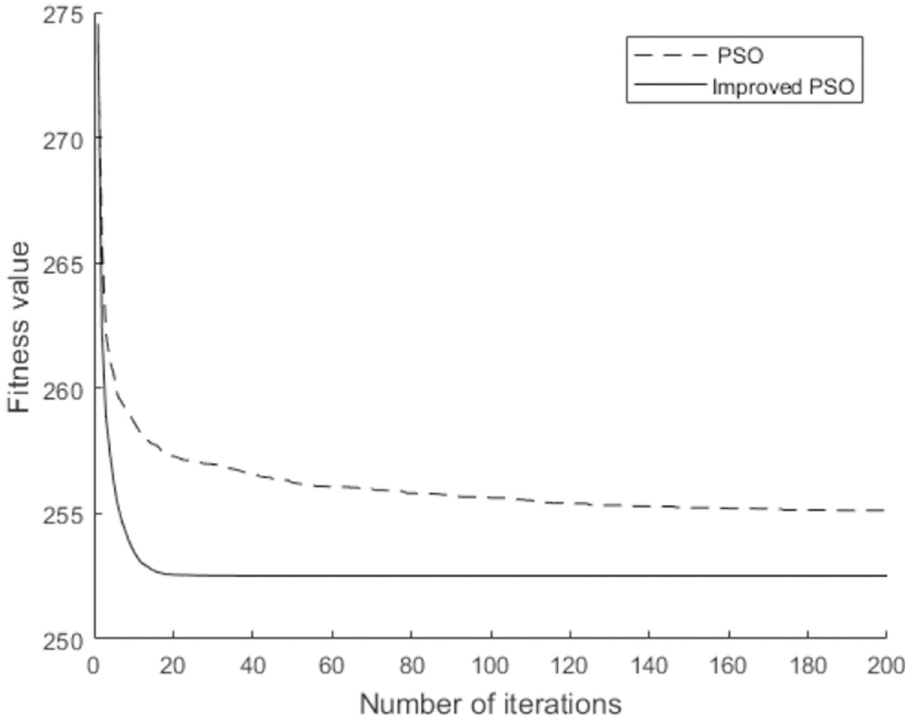
Fig 8. Comparison of the algorithm evolution